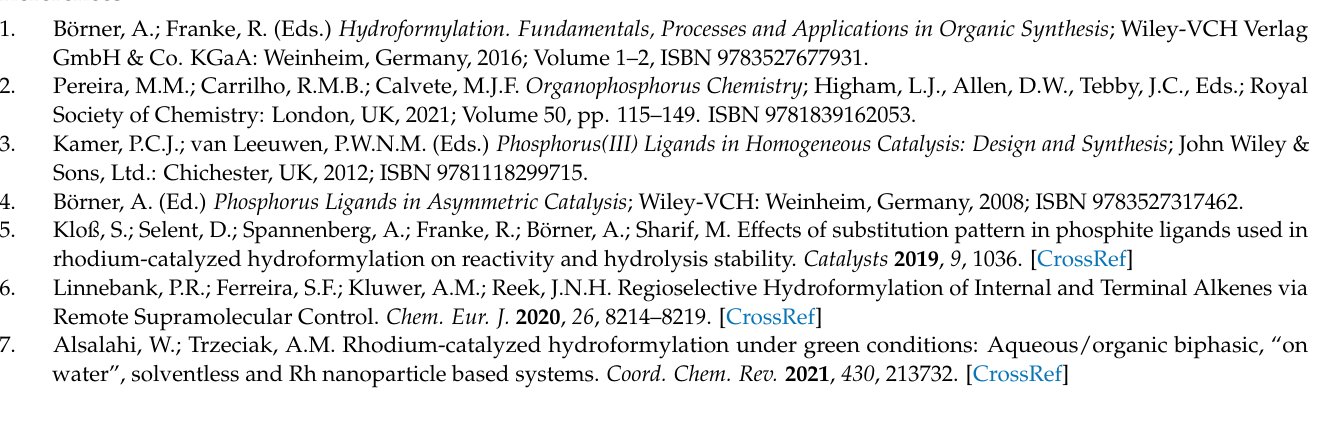
neomenthol ( 1 ); Figure S4: 1 H NMR spectrum of ( R )-BINOL-(+)-neomenthol ( 2 ) in CDCl 3 ; Figure S5: 13 C NMR spectrum of ( R )-BINOL-(+)-neomenthol ( 2 ) in CDCl 3 ; Figure S6: HRMS spectrum of ( R )- BINOL-(+)-neomenthol ( 2 ); Figure S7: 1 H NMR spectrum of ( S )-BINOL-(+)-neomenthol ( 3 ) in CDCl 3 ; Figure S8: 13 C NMR spectrum of ( S )-BINOL-(+)-neomenthol ( 3 ) in CDCl 3 ; Figure S9: HRMS spectrum of ( S )-BINOL-(+)-neomenthol ( 3 ); Figure S10: COSY spectrum of ( S )-BINOL-(+)-neomenthol ( 3 ) in CDCl 3 ; Figure S11: HMBC spectrum of ( S )-BINOL-(+)-neomenthol ( 3 ) in CDCl 3 ; Figure S12: HSQC spectrum of ( S )-BINOL-(+)-neomenthol ( 3 ) in CDCl 3 ; Figure S13: 13 C NMR (1) and DEPT 135 (2) spectra of ( S )-BINOL-(+)-neomenthol ( 3 ) in CDCl 3 .; Table S1: 1 H and 13 C NMR assignments for 3 ; Figure S14: 1 H NMR spectrum of ( R )-BINOL-(–)-neomenthol ( 4 ) in CDCl 3 ; Figure S15: 1 H NMR spectrum of ( R )-BINOL-(–)-neomenthol ( 4 ) in CDCl 3 ; Figure S16: HRMS spectrum of ( R )-BINOL- (–)-neomenthol ( 4 ); Figure S17: 1 H NMR spectrum of L1 in CDCl 3 ; Figure S18: 31 P NMR spectrum of L1 in CDCl 3 ; Figure S19: 1 H NMR spectrum of L2 in CDCl 3 ; Figure S20: 13 C NMR spectrum of L2 in CDCl 3 ; Figure S21: 31 P NMR spectrum of L2 in CDCl 3 ; Figure S22: 1 H NMR spectrum of L3 in CDCl 3 ; Figure S23: 13 C NMR spectrum of L3 in CDCl 3 ; Figure S24: 31 P NMR spectrum of L3 in CDCl 3 ; Figure S25: 1 H NMR spectrum of L4 in CDCl 3 ; Figure S26: 13 C NMR spectrum of L4 in CDCl 3 ; Figure S27: 31 P NMR spectrum of L4 in CDCl 3 ; Figure S28: HRMS (MALDI-TOF) spectrum of L4 ; Table S2: Selected crystallographic data for compounds 1 - 4